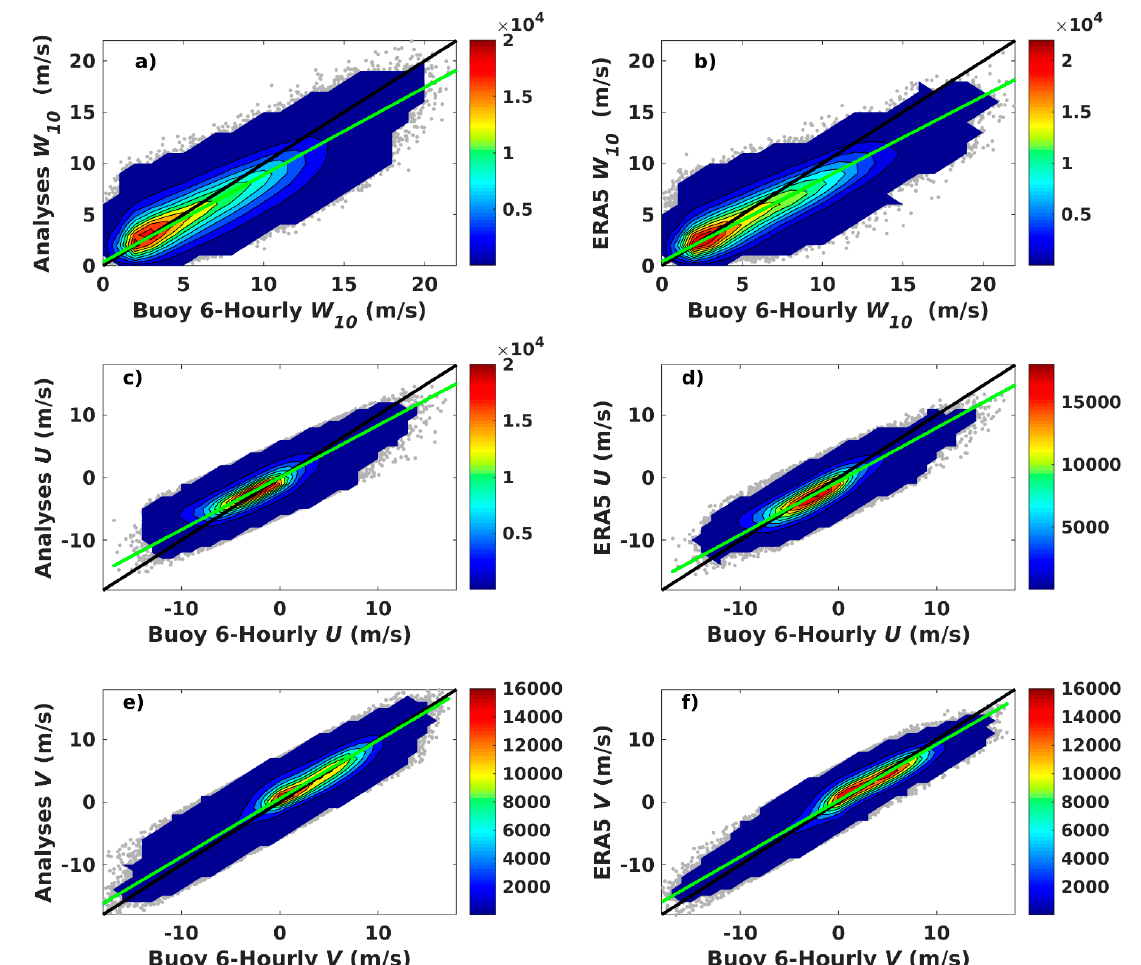
Figure 5. As Figure 4 but for nearshore comparisons.